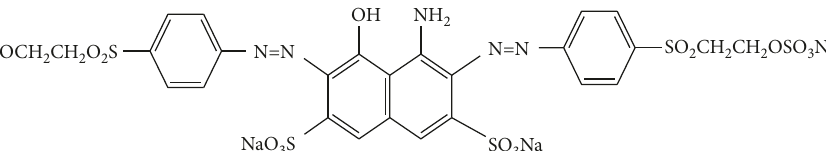
Scheme 1: Molecular structure of